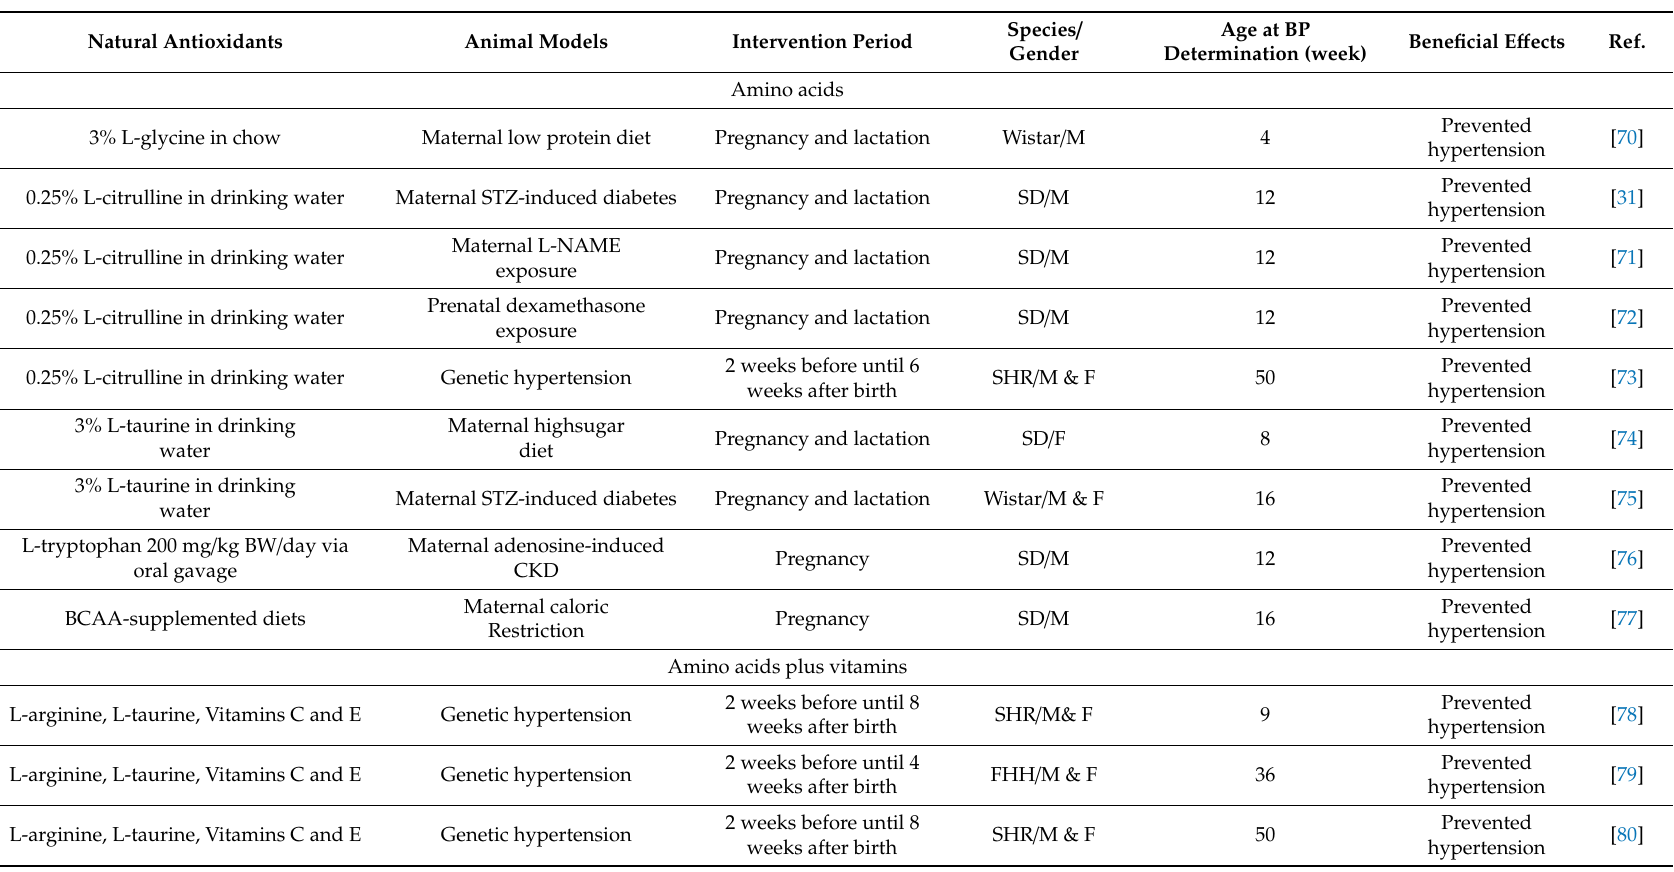
Table 2. Animal models dealing with natural antioxidants for hypertension